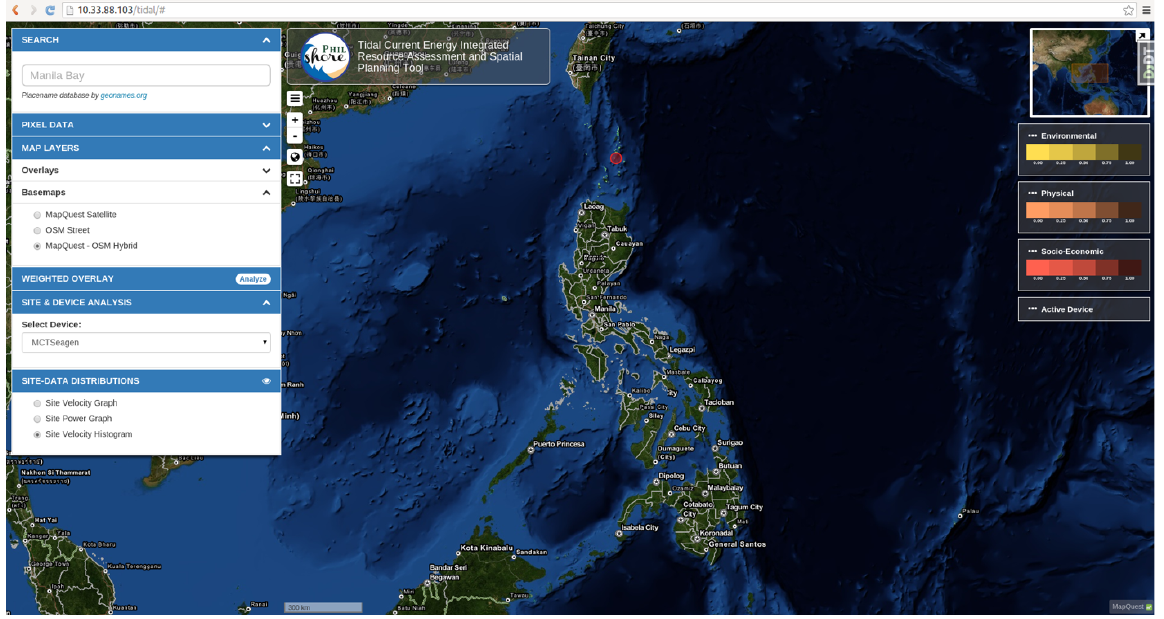
Figure 5. Screenshot of the marine spatial planning (MSP) tool prototype (a) basemap; (b) layer overlay; (c) site power map.